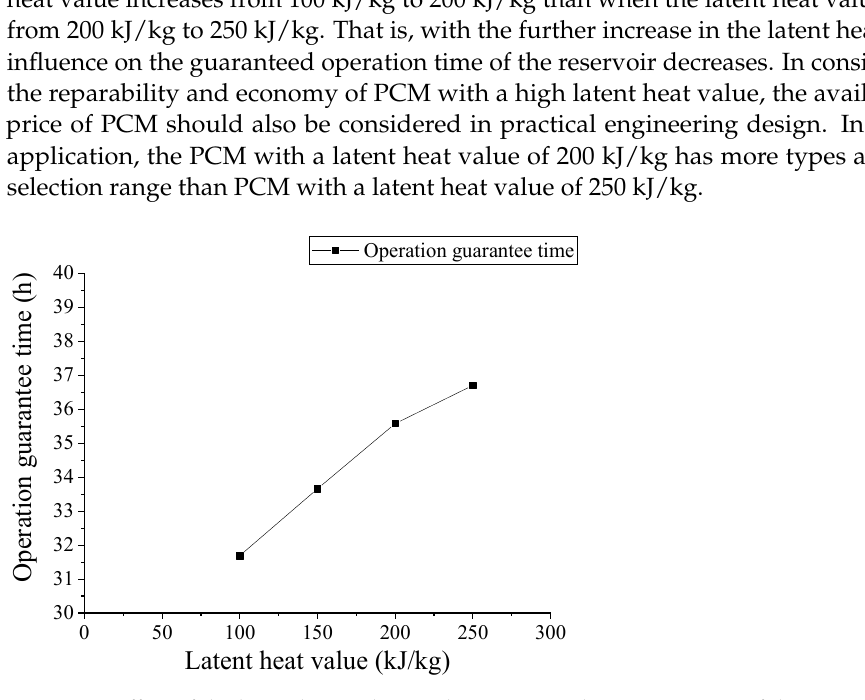
Figure 12. Effect of the latent heat value on the guaranteed operation time of the reservoir. Table 5 shows the analysis of the influence of different latent heat values on the heat storage performance of the reservoir, wherein the working condition “0” refers to the